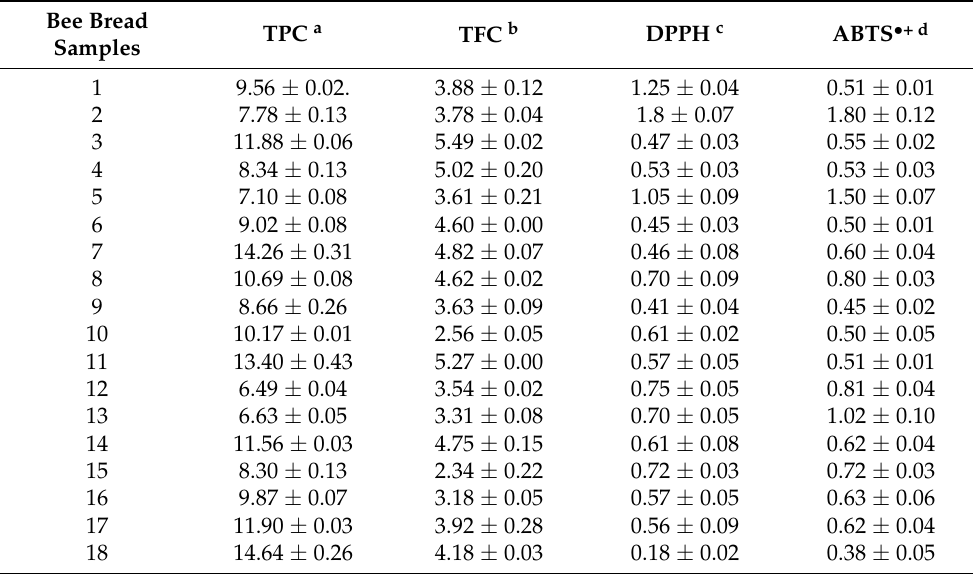
Table 1. TPC, TFC, DPPH, and ABTS • + of bee bread samples. Bee Bread